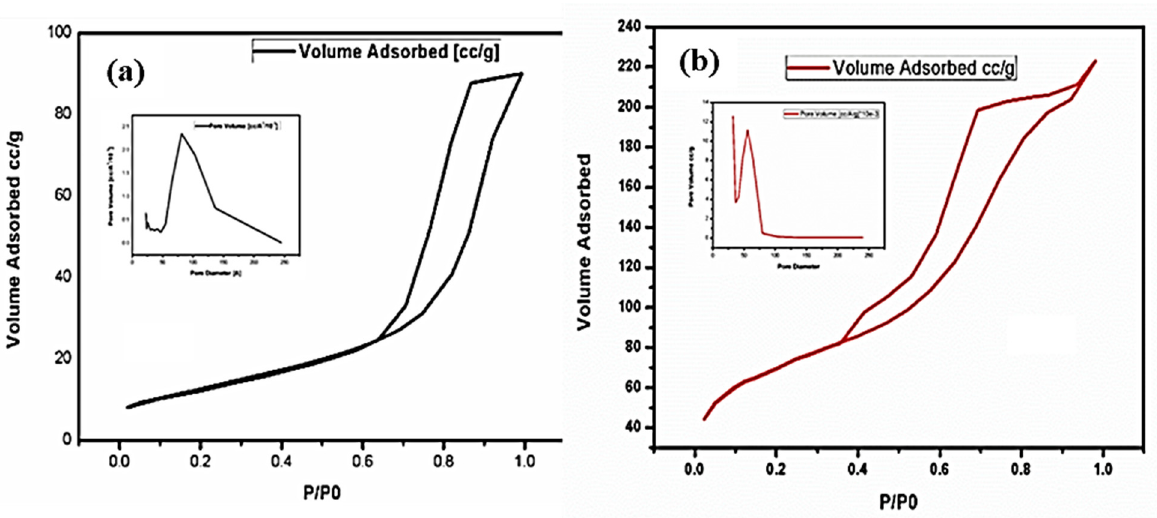
Figure 2. BET absorption spectra of ( a ) unsupported TiO 2 and ( b ) supported AC/TiO 2 .